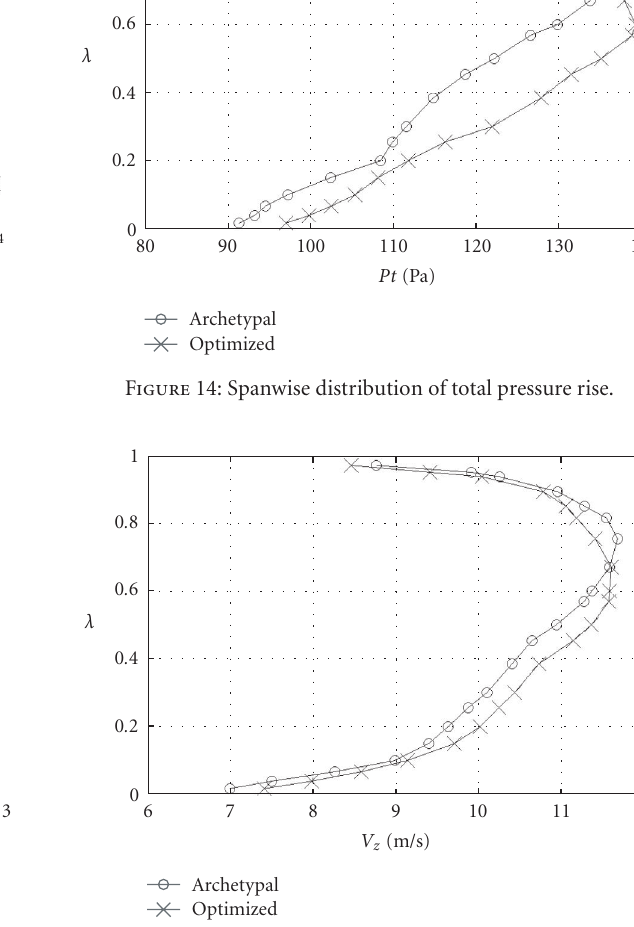
Figure 13: Spanwise distribution of total pressure loss coe ffi cient.